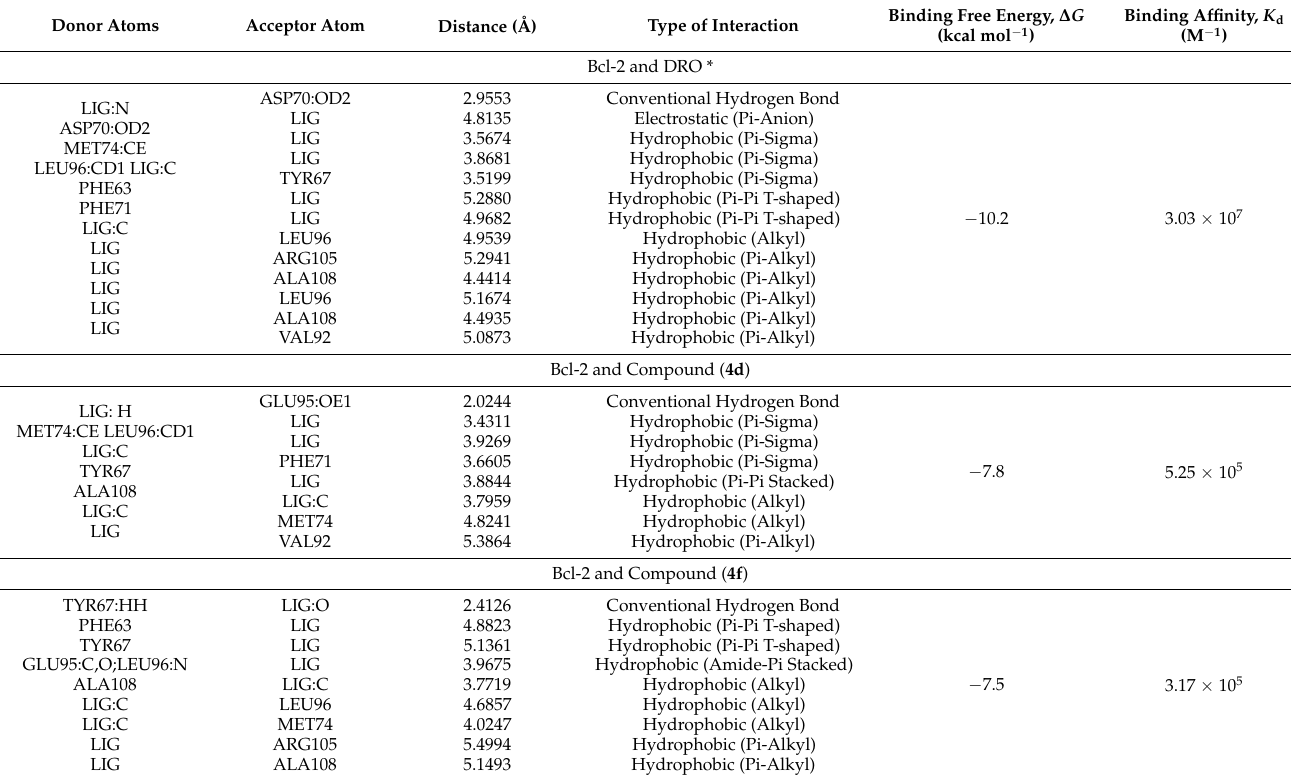
Table 2. Molecular docking of compound 4d and 4f with